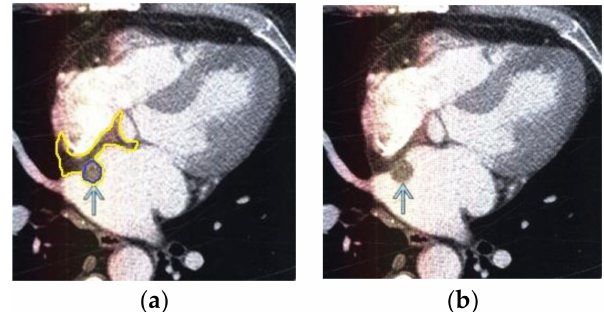
Figure 4. Heart MRI: ( a ) image with white noise and ( b ) denoised image with contrast enhancement of volumetric heterogeneous formation.